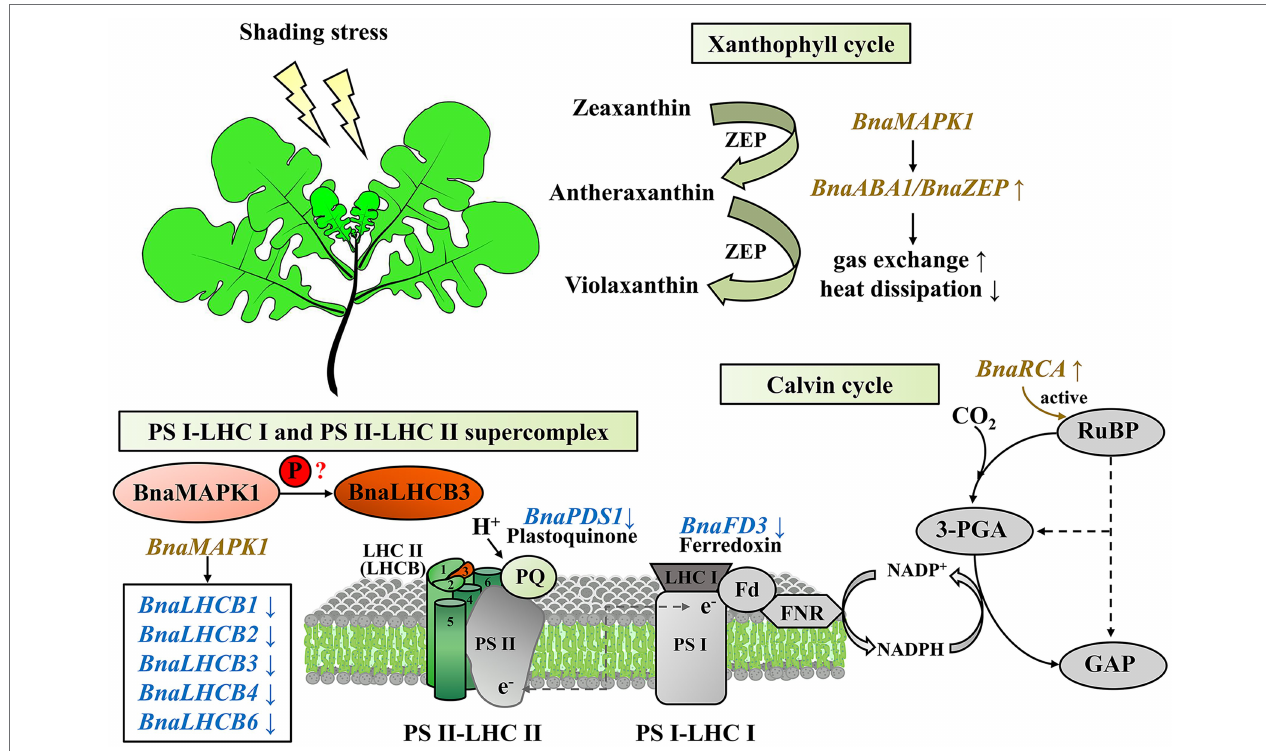
FIGURE 7 | A proposed working model of BnaMAPK1 functions in photosynthesis under shading stress in Brassica napus